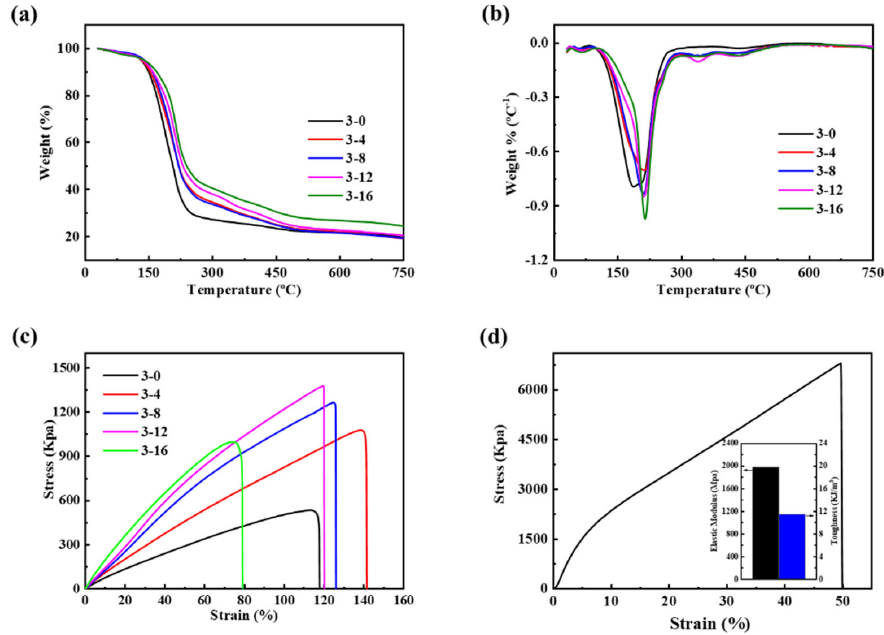
Figure 3. The ( a ) TG and ( b ) DTA curves of GPE; ( c ) stress-strain curves of GPE; ( d ) Stress-strain curves of GPE 3-12 after immersed in 5 mol L − 1 ZnCl 2 and 4 mol L − 1 LiCl.